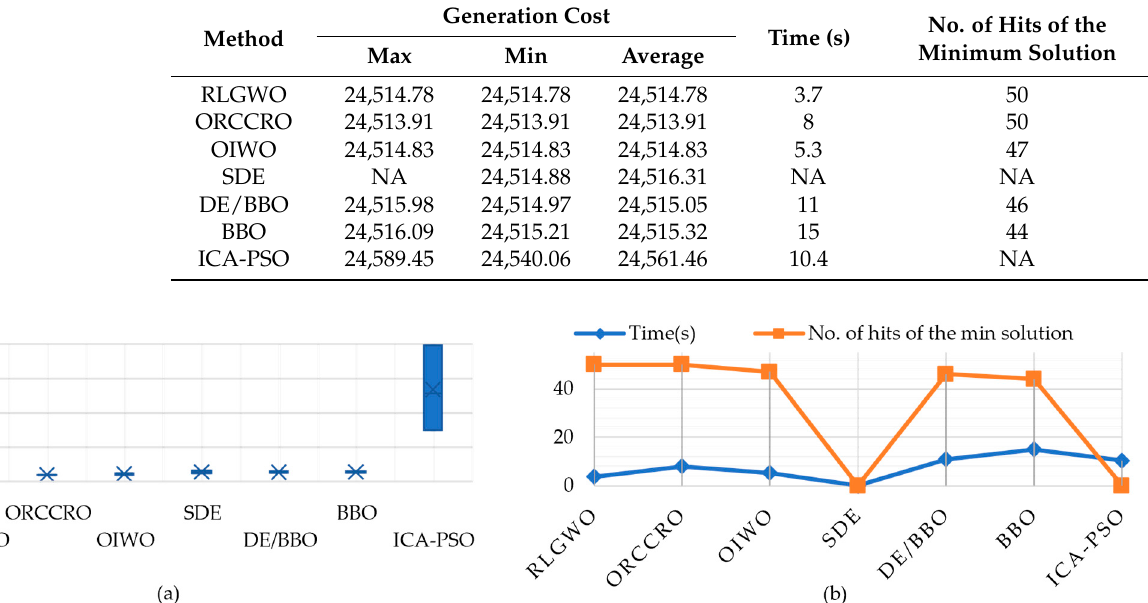
Figure 5. Results for different methods for the 13-unit system (50 trials): ( a ) boxplot of the final generation cost; ( b ) time and number of hits of the minimum solution.